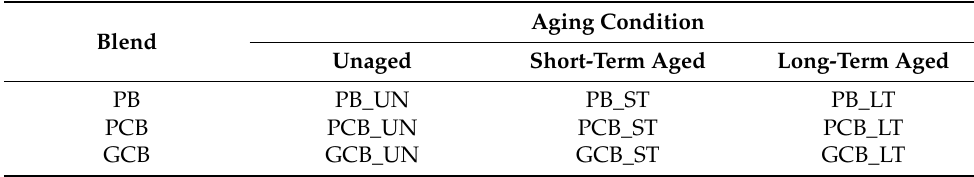
Table 3. Code of the